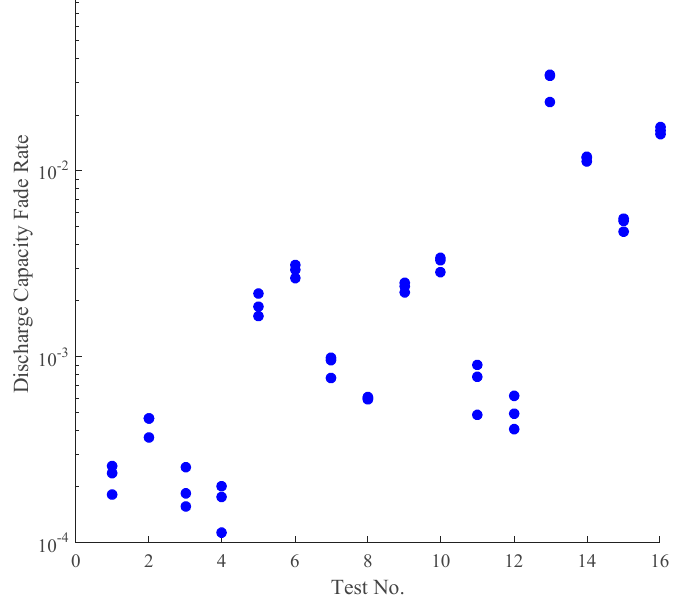
Figure 1. Variation of discharge capacity with cumulative discharge (Ah) for Manufacturer 1.